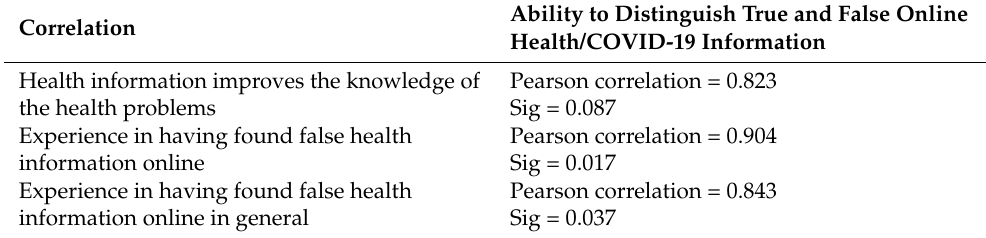
Table 11. Positive correlations resulted from the